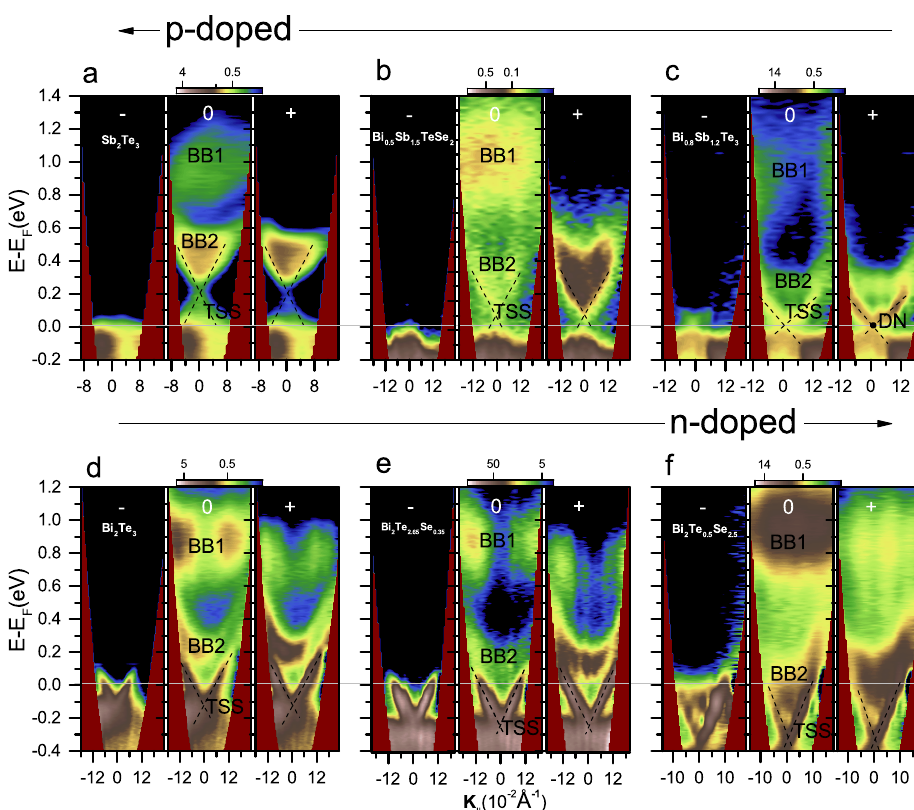
Figure 2. TARPES snapshots of six BSTS samples: ( a ) Sb 2 Te 3 , ( b ) Bi 0.5 Sb 1.5 TeSe 2 , ( c ) Bi 0.8 Sb 1.2 Te 3 , ( d ) Bi 2 Te 3 , ( e ) Bi 2 Te 2.65 Se 0.35 , and ( f ) Bi 2 Te 0.5 Se 2.5 . For each sample three different pump-probe delays are shown: negative (“–” label, left) i.e., the equilibrium condition, zero (“0” label, center), + 1 ps (“+” label, right). Fermi level is shown by the gray horizontal lines. Dashed black lines are guides to the eye, showing the topological surface states (TSS). Bulk bands (BB1 and BB2) are clearly visible at zero delay. Passing from panel ( a ) to panel ( f ) the samples are progressively n-doped. Color intensity maps are on a logarithmic